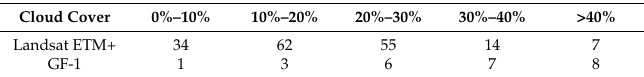
Table 2. Number of images with different cloud covers.